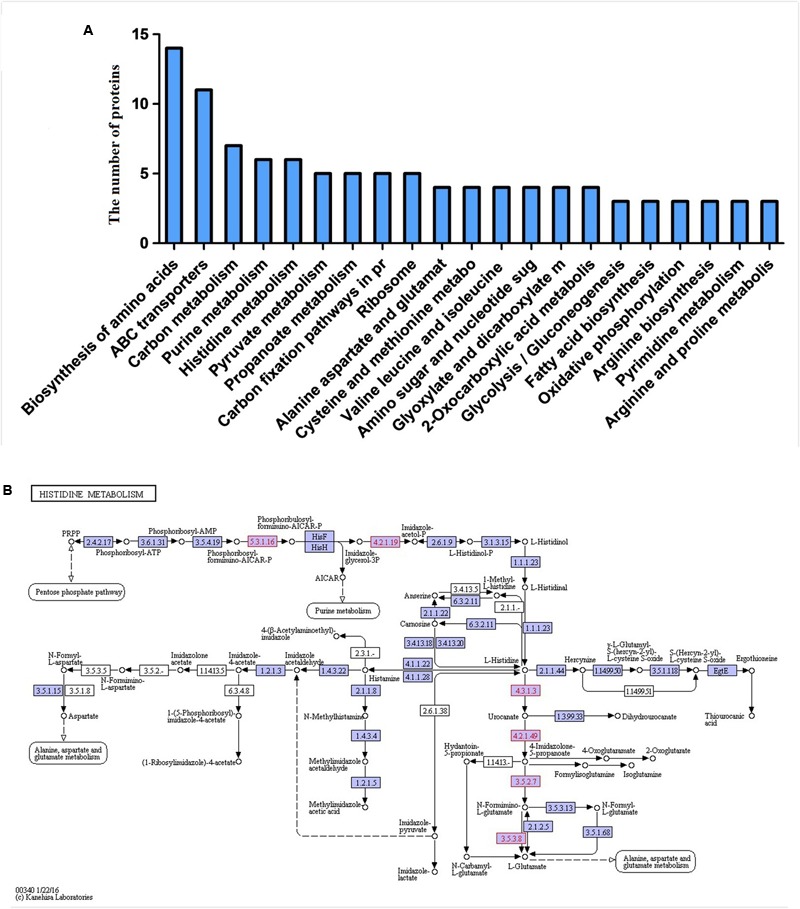
(A) Proteins involved in KEGG pathways. (B) Protein expression profiles during biofilm formation following treatment with aspirin mapped onto the histidine metabolism pathway. Changes in enzymes (proteins) are marked in green and mapped onto KEGG pathways.